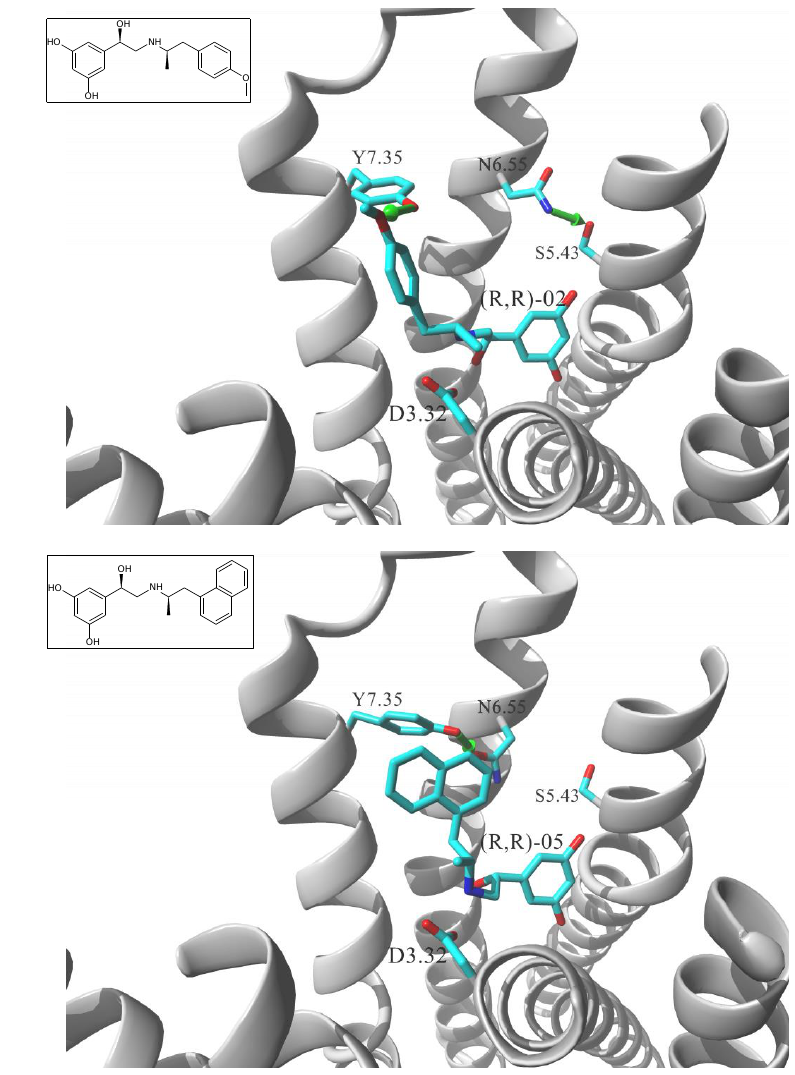
Figure 1. Postulated mechanism of differential interactions between β 2 -AR molecule and ( A ) ( R , R )-02, (a ligand inducing G s signaling pattern), or ( B ) ( R , R )-05, a ligand inducing [G s +G i ] signaling pattern. The receptor molecule is shown in secondary structure mode (gray ribbon), parts are hidden for clarity. Ligands molecules and Y308 7.35 , N293 6.55 , S204 5.43 and D113 3.32 residues are rendered in stick mode, key HBs discussed in the text are shown as green arrows. Inset: chemical formula of a ligand. Adopted from [27].